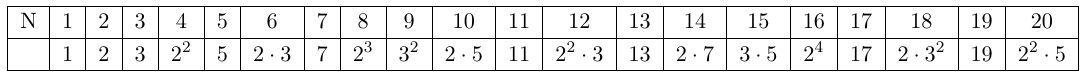
Table 1 . The prime factorization of positive integer 0 < N < 21